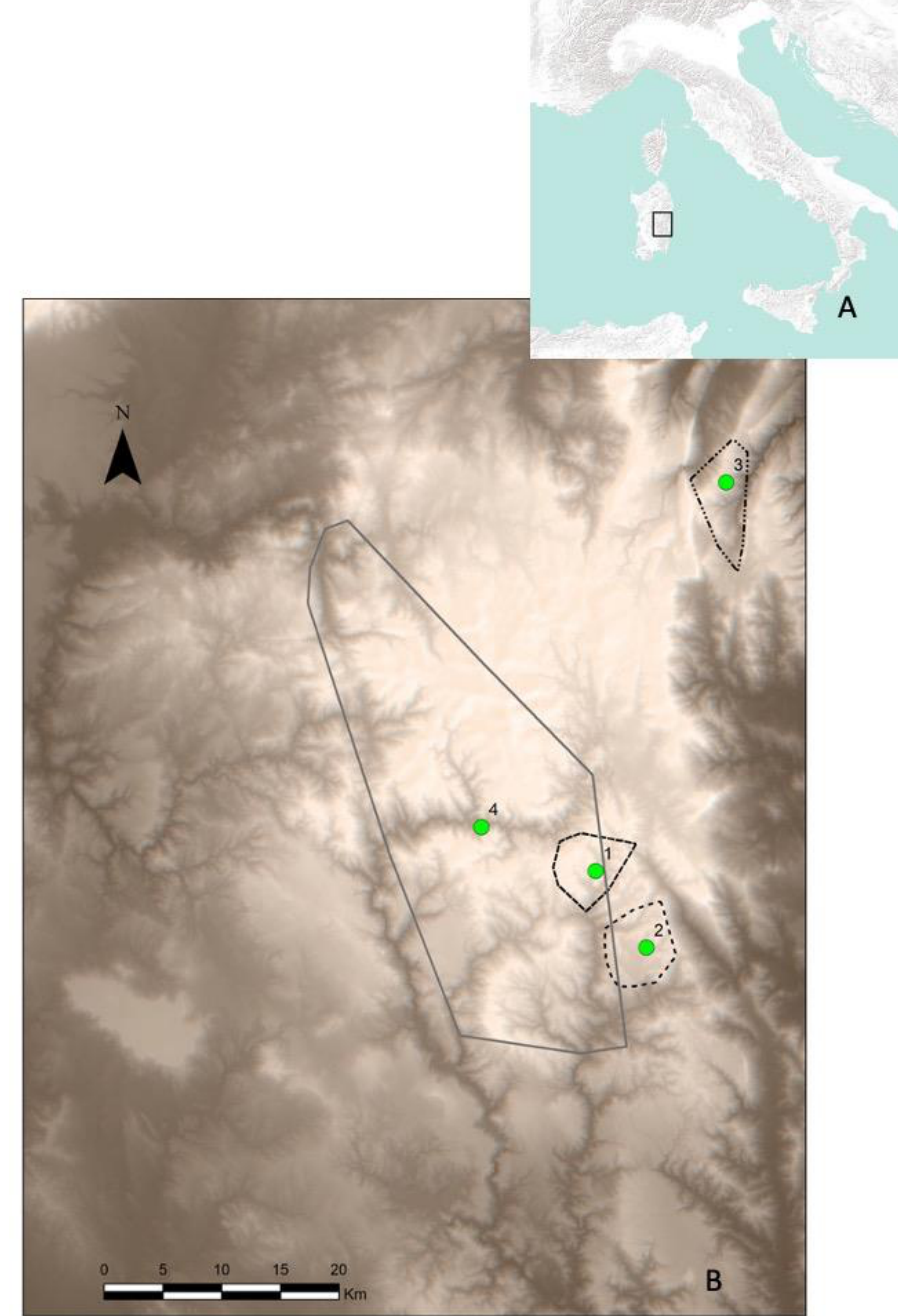
Figure 1. ( A ) Italy; ( B ) Sardinian study area: green dots are the reintroduction sites (1, Montarbu; 2, Taccu; 3, Sa Portisca; 4, Rio Nuxi); lines are the outermost locations of Corsican red deer tracked in this study.